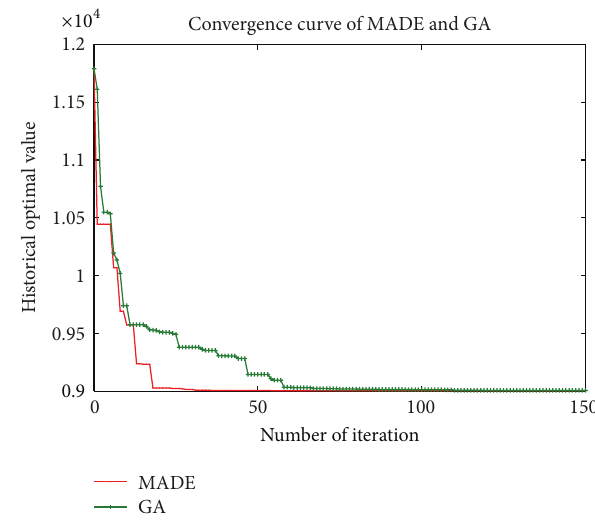
Figure 2: Convergence curve of MADE and